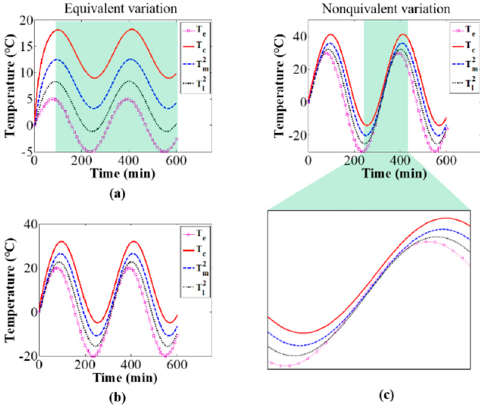
Figure 11. Effect of environmental temperature variation rate on camera components temperature: ( a ) T e = 5sin ( t /50 ) , ( b ) T e = 20sin ( t /50 ) , and ( c ) T e = 30sin ( t /50 )